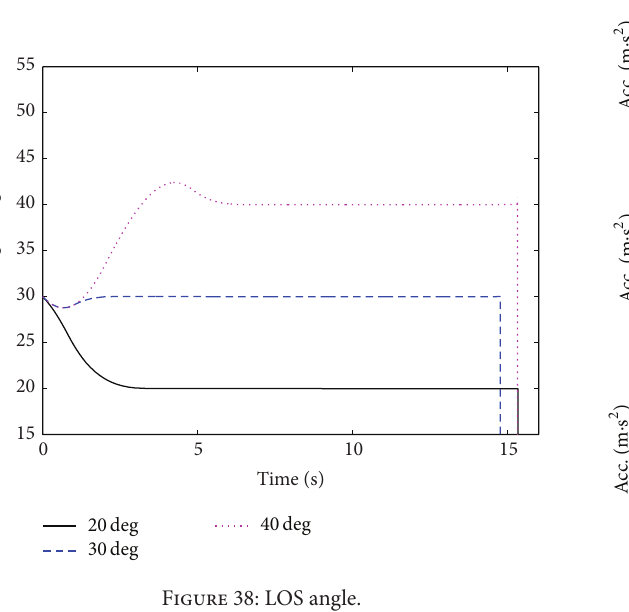
Figure 40: Missile